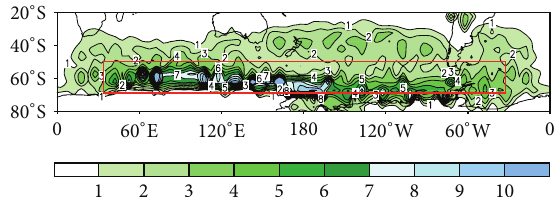
Figure 1: Area (red rectangle) chosen for analysis of differences between reanalysis datasets shown in Table 2. NCEP1 5010 used for template.